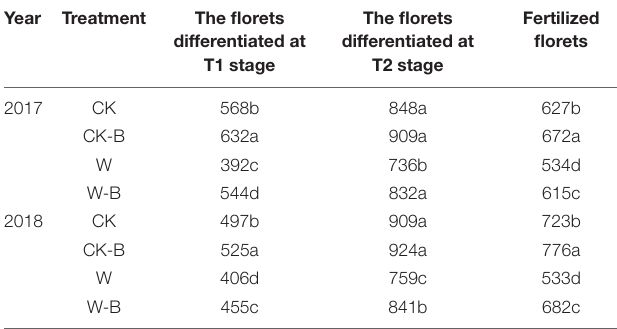
Different letters on bars indicate the significant differences among treatments at P < 0.05 using the LSD